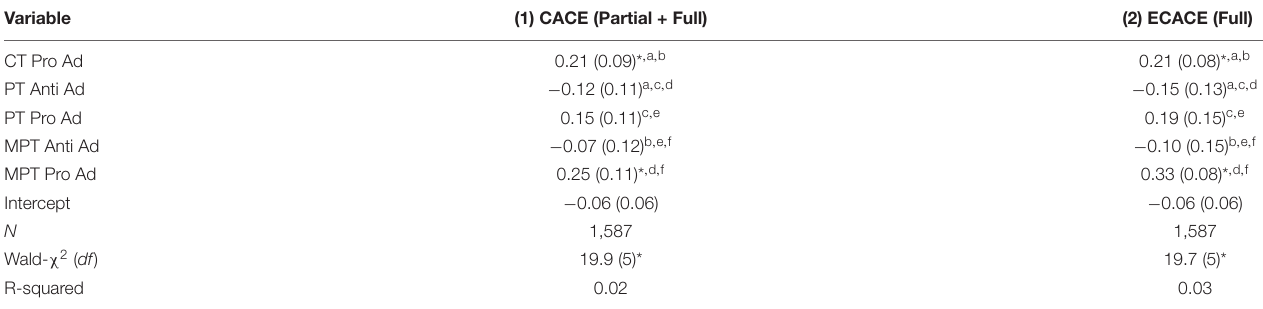
TABLE 4 | Regression results on the transgender rights scale (Study 2).